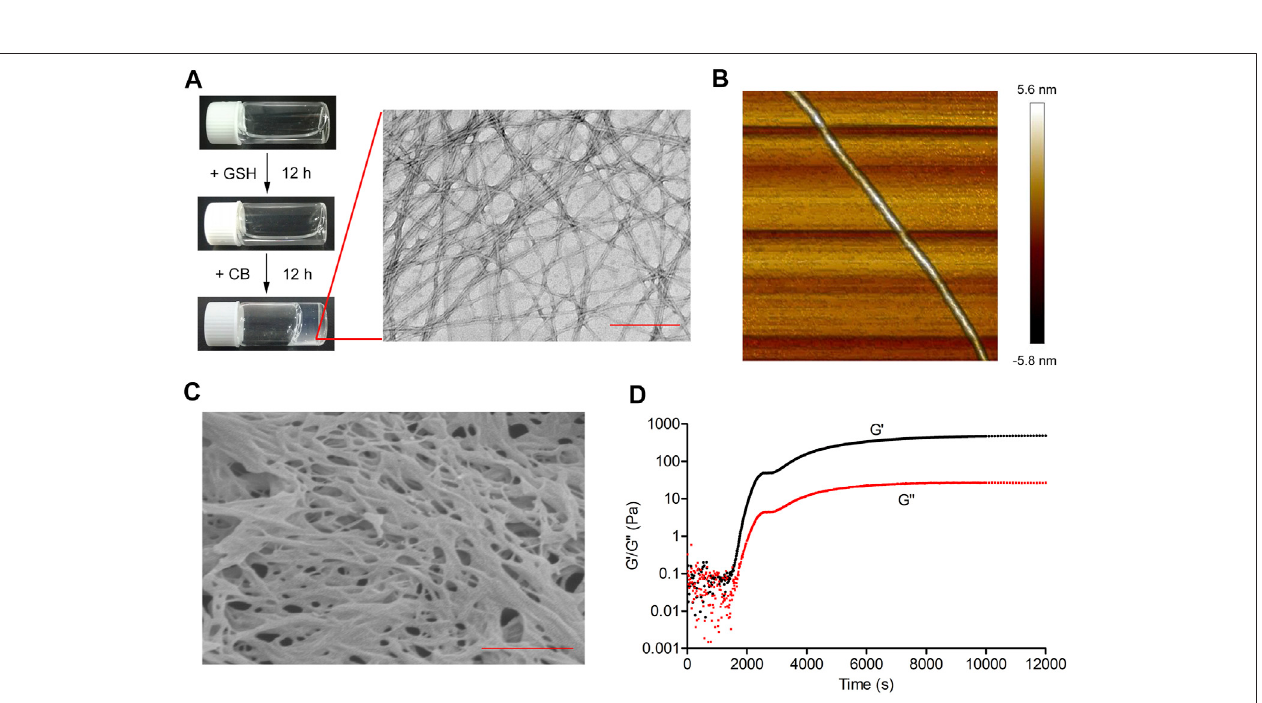
Frontiers in Pharmacology |